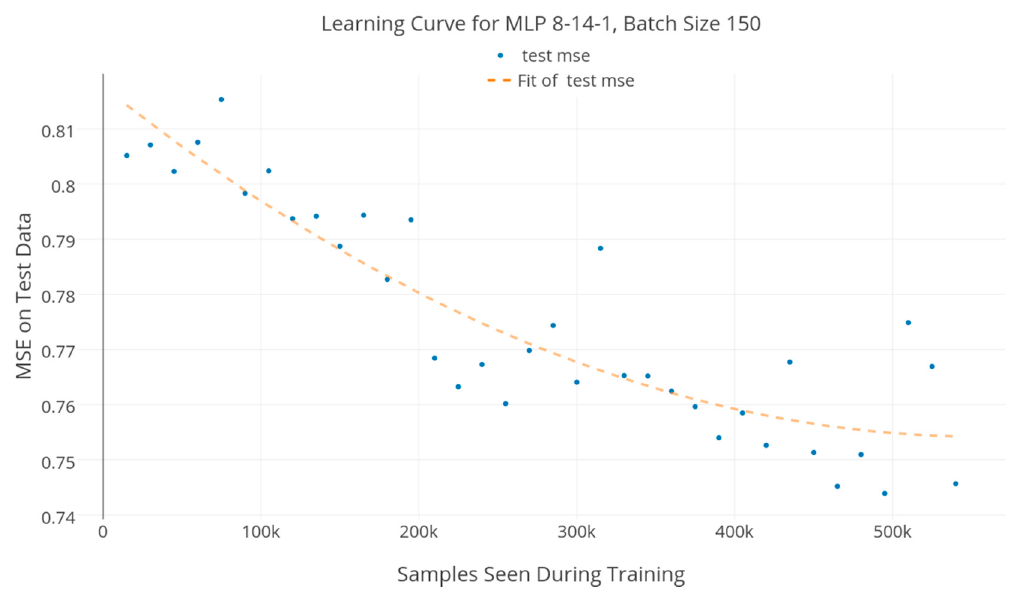
Figure 9. Learning curve of final MLP model.